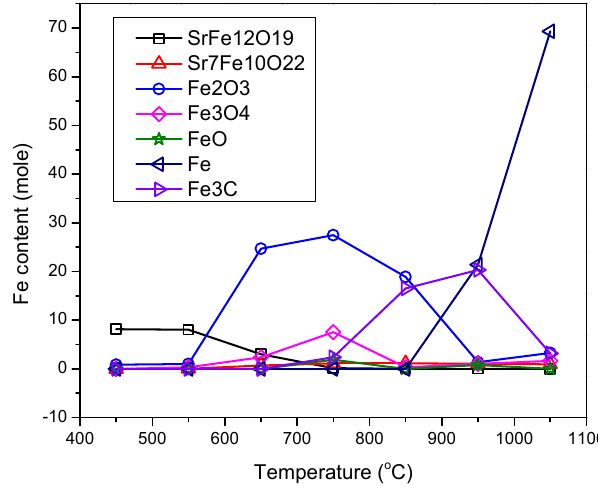
Figure 6. Amount of Fe content in different phases in the samples obtained by CH 4 heat treatment at different temperatures (normalized on the basis of supposing that the initial amount of Fe in the sample was 100 moles).